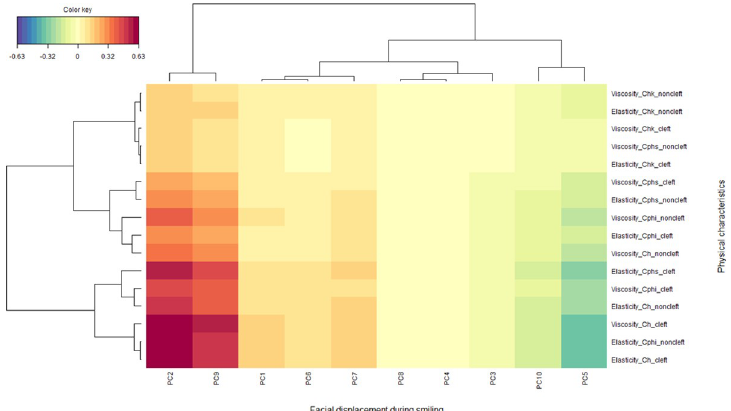
Fig 8. Heatmap showing the correlation between the facial displacement while smiling, represented as the principal component (PC), and the physical characteristics of the skin according to a canonical correlation analysis. The X-axis depicts the 3D facial displacement while smiling represented as PCs 1–10 and the Y-axis the viscoelasticity of the skins tested. The red and blue colors indicate strong positive and negative correlations, respectively, whereas yellow indicates weaker correlation values (see color key). The “mixOmics” tool as part of the R software package was used to draw this figure.